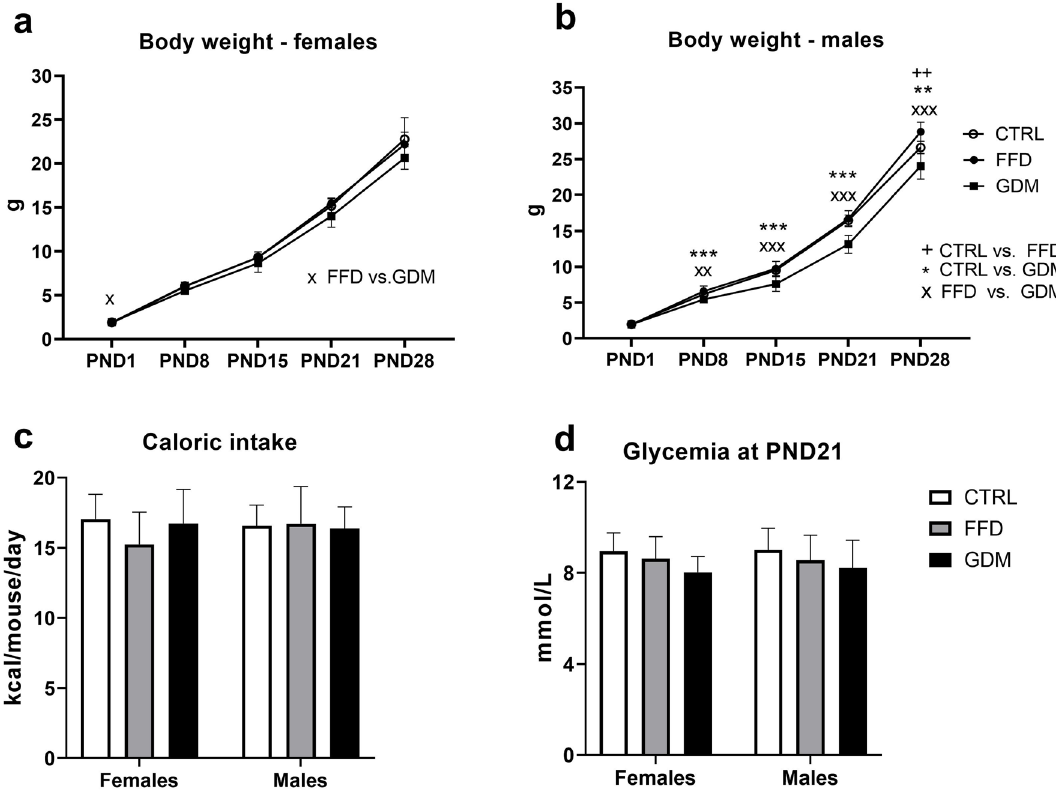
Figure 2. ( a ) Body weight curve in female offspring: p group = 0.015, p time < 0.001, p group*time interaction = 0.014; ( b ) body weight curve of male offspring: p group < 0.001, p time < 0.001, p group*time interaction < 0.001; ( c ) mean caloric intake per day: p group = 0.688, p sex = 0.356, p group*sex interaction = 0.224; ( d ) glycemia: p group = 0.043, p sex = 0.810, p group*sex interaction = 0.922; groups: CTRL offspring of dams consuming control diet, FFD offspring of dams administered fast-food diet (cheeseburgers), GDM offspring of dams with gestational diabetes mellitus; x p < 0.05; ** ,xx,++ p < 0.01; *** ,xxx p < 0.001.